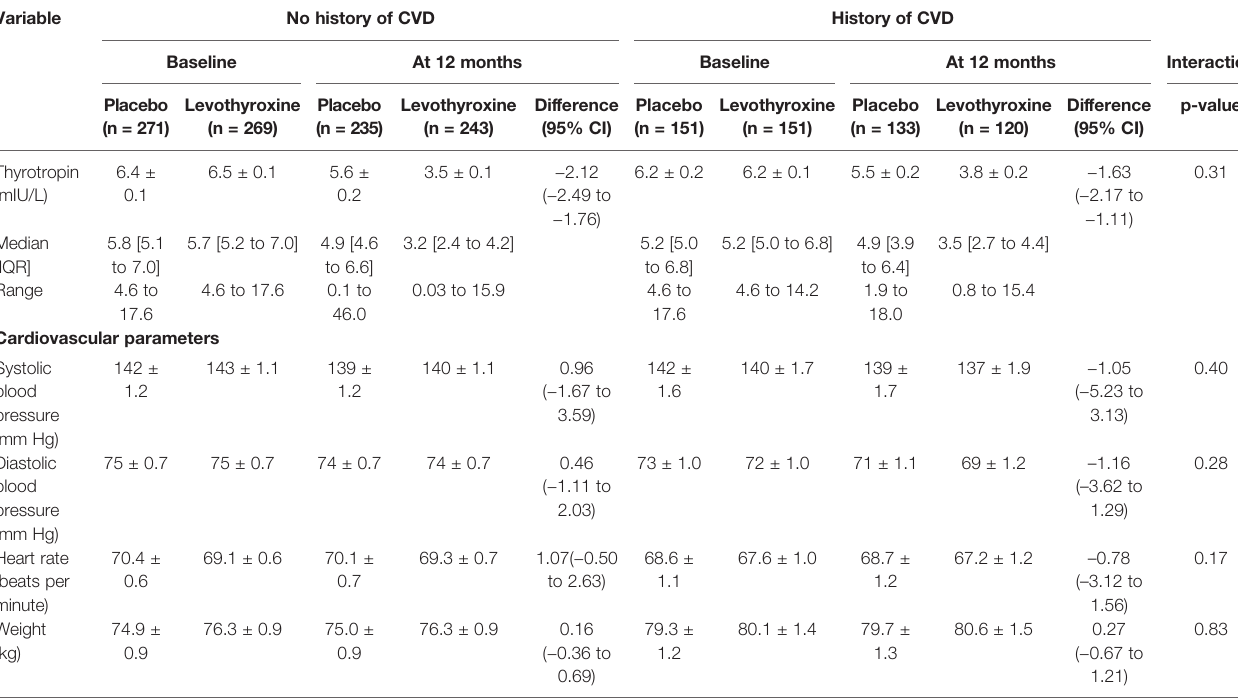
Values are mean ± standard error (SE). CI, con fi dence interval; CVD, cardiovascular disease. Results at 12 months and between-group differences are adjusted for strati fi cation variables (country, sex, starting dose of levothyroxine and study as random effect) and baseline levels of the same variable with the use of linear mixed models. Between-group differences are the